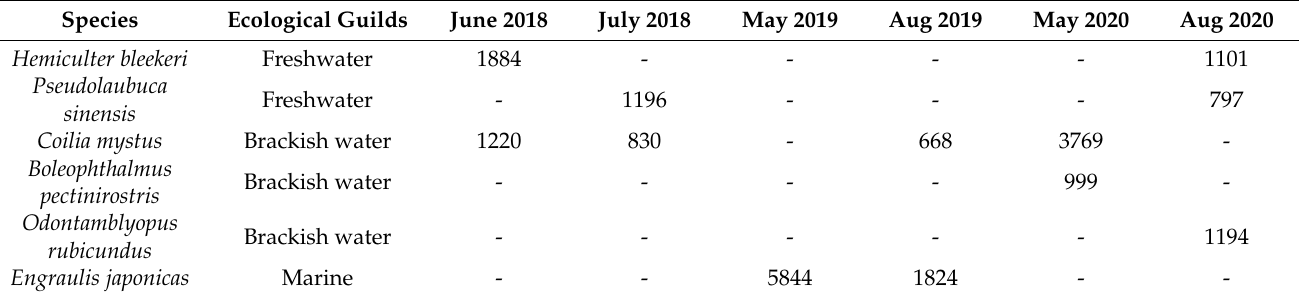
Table 3. IRI (IRI > 500) of dominant species of different ecological guilds in the Yangtze Estuary. Species Ecological